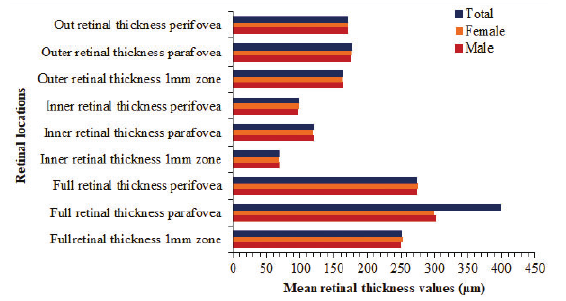
Figure 3. Mean retinal thickness measurements (µm) at different locations in male and female Saudi participants.